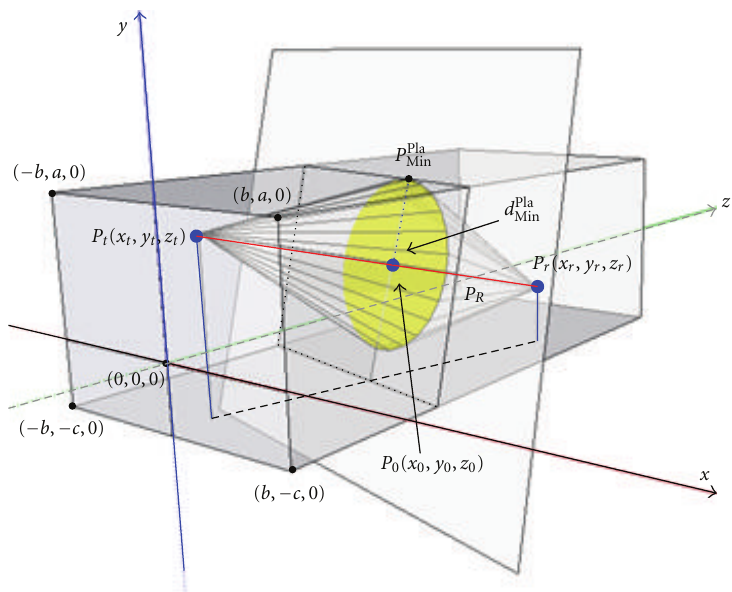
Figure 3: Detailed schematic diagram of the propagation inside rectangular tunnels with the first Fresnel zone clearance.